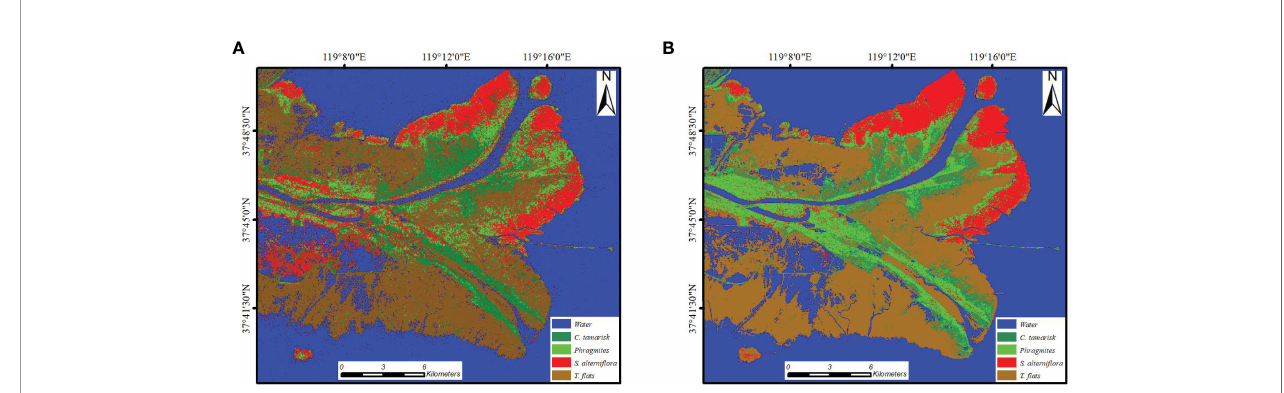
FIGURE 10 | Classi fi cation results of different methods in 2018. (A) is the multi-temporal classi fi cation results based on SVM method. (B) is the classi fi cation results based on constructed decision tree.